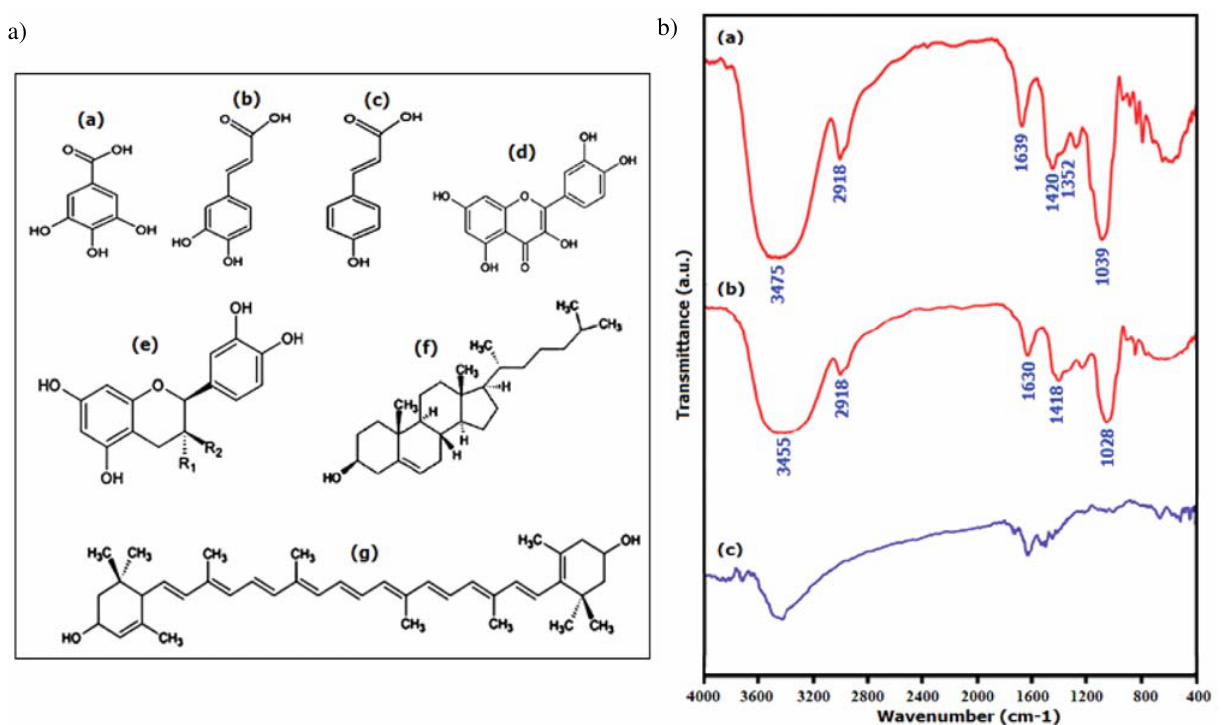
Figure 9. (A) The structure of some of phytochemicals present in Date fruits: (a)-(c) Phenolic acids, (d) a Flavonoid, (e) a Procyanidin, (f) a Sterol, (g) a Carotenoid. (B) FT-IR spectra of: (a) Date palm fruit extract, (b) Ag NPs capped with Date fruit extract solution and (c) Ag NPs after washing with deionized